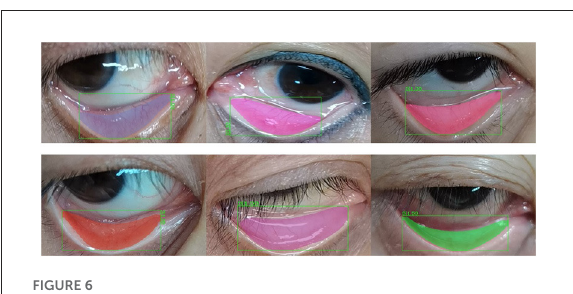
FIGURE6 Schematic diagram of segmentation